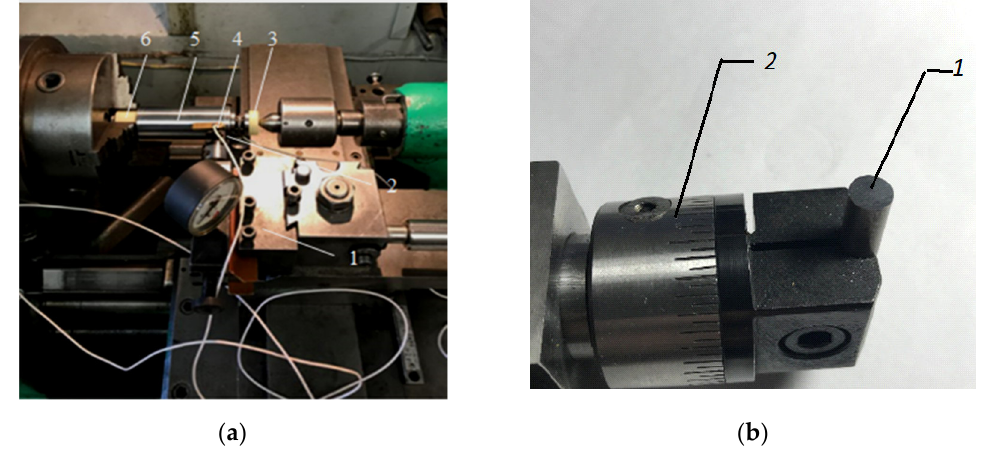
Figure 3. Installation for burnishing on a T37 lathe (RAMO, Paris, France) ( a ) a sample on a lathe: 1—tool support bar, 2—toolholder with indenter, 3, 6—heat-insulating bushings, 4—dynamic ther- mocouple, 5—a sample; ( b ) device for burnishing: 1—cylindrical indenter, 2—toolholder.